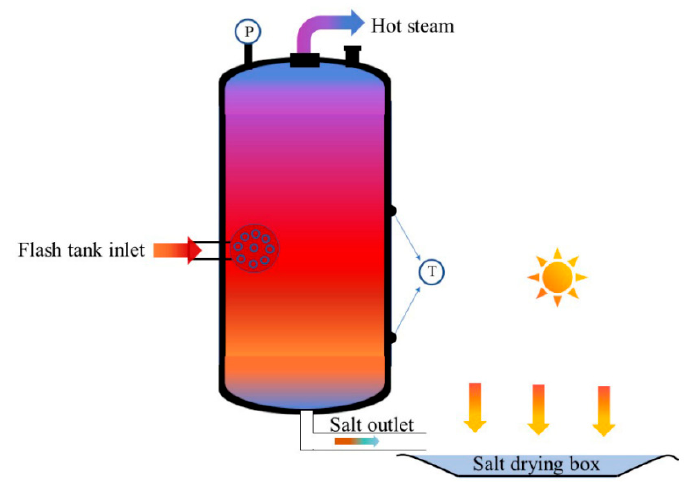
Figure 4. Structural diagram of flash tank and salt drying tank. 5. Shell-and-tube circulating condenser: The shell-and-tube circulating condenser is a general-purpose device used for heat exchange, characterized by high heat transfer efficiency and low flow resistance. The condenser, 0.6 m in diameter and 2.1 m in height, contains a total of 256 heat exchange tubes. Cooling water running between the heat exchange tubes facilitates rapid condensation of the vapor; cooling water flows into the shell-and-tube circulating condenser from the bottom and flows out from the top. As a coolant in continuous supply, cooling water condenses vapor in the shell-and-tube circulating condenser into fresh water. The vapor enters the shell-and-tube circulating condenser via the left inlet and fresh water is discharged via the right outlet. The structure of the shell-and-tube circulating condenser is shown in Figure 5. Under the action of the water-ring vacuum pump, pressure and temperature of the vapor in the shell-and-tube circulating condenser both decline, reducing heat loss of the vapor and increasing the condensation efficiency of the shell-and-tube circulating condenser.